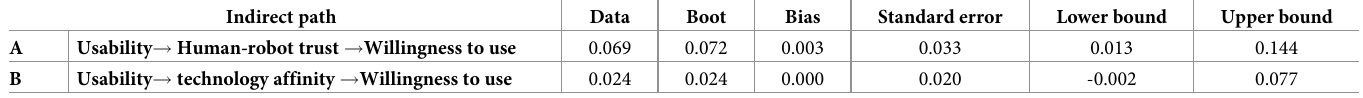
Table 3. Results of bootstrapping.